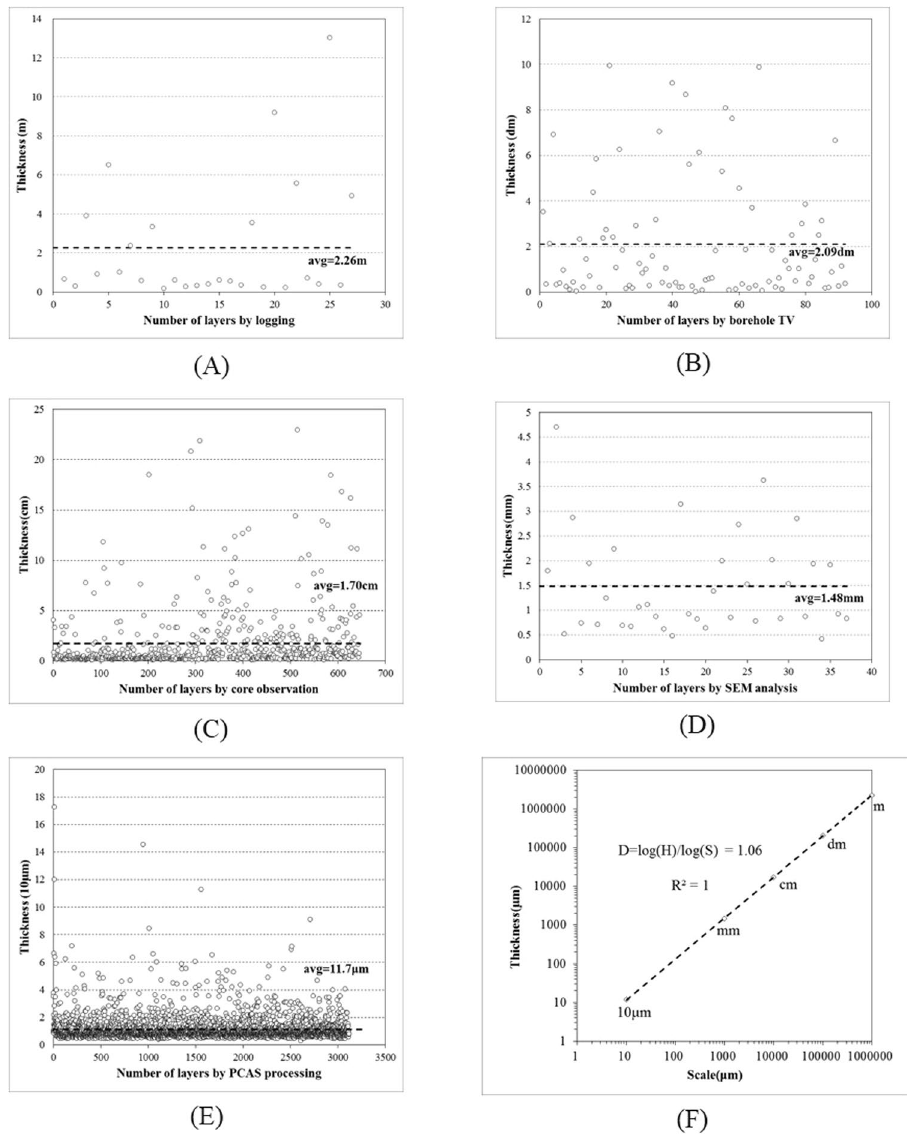
Figure 5. Multi-scale thicknesses and fractal features of the Chang 7 Member shale. ( A ) Thickness distribution of laminas stratified by logging curves at the meter scale. ( B ) Thickness distribution of layers stratified by borehole TV at the decimeter scale. ( C ) Thickness distribution of layers stratified by core observation at the centimeter scale. ( D ) Thickness distribution of layers stratified by SEM image processing at the millimeter scale. ( E ) Layer thickness statistics by PCAS processing at the micrometer scale. ( F ) Double-logarithmic curve of layer thickness and measurement